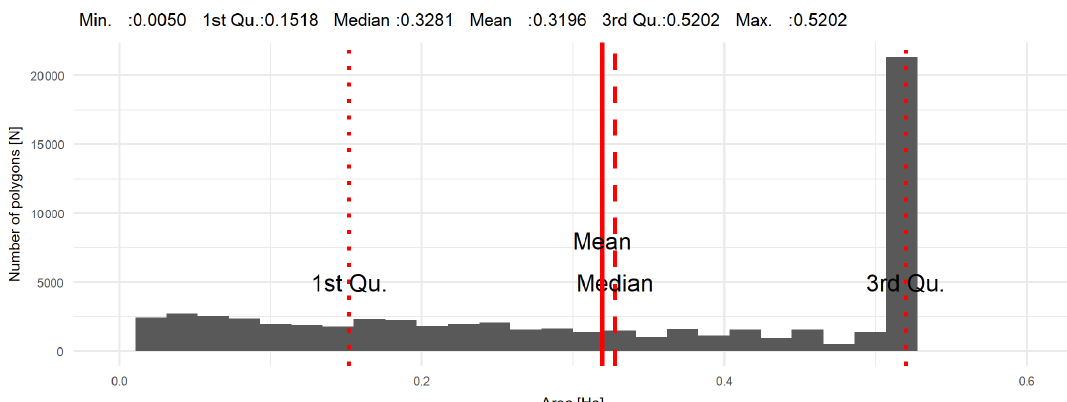
Figure 2. Distribution of the area of the LUCAS Copernicus polygons in hectares ( N = 63287). On average, the polygon covers an area of